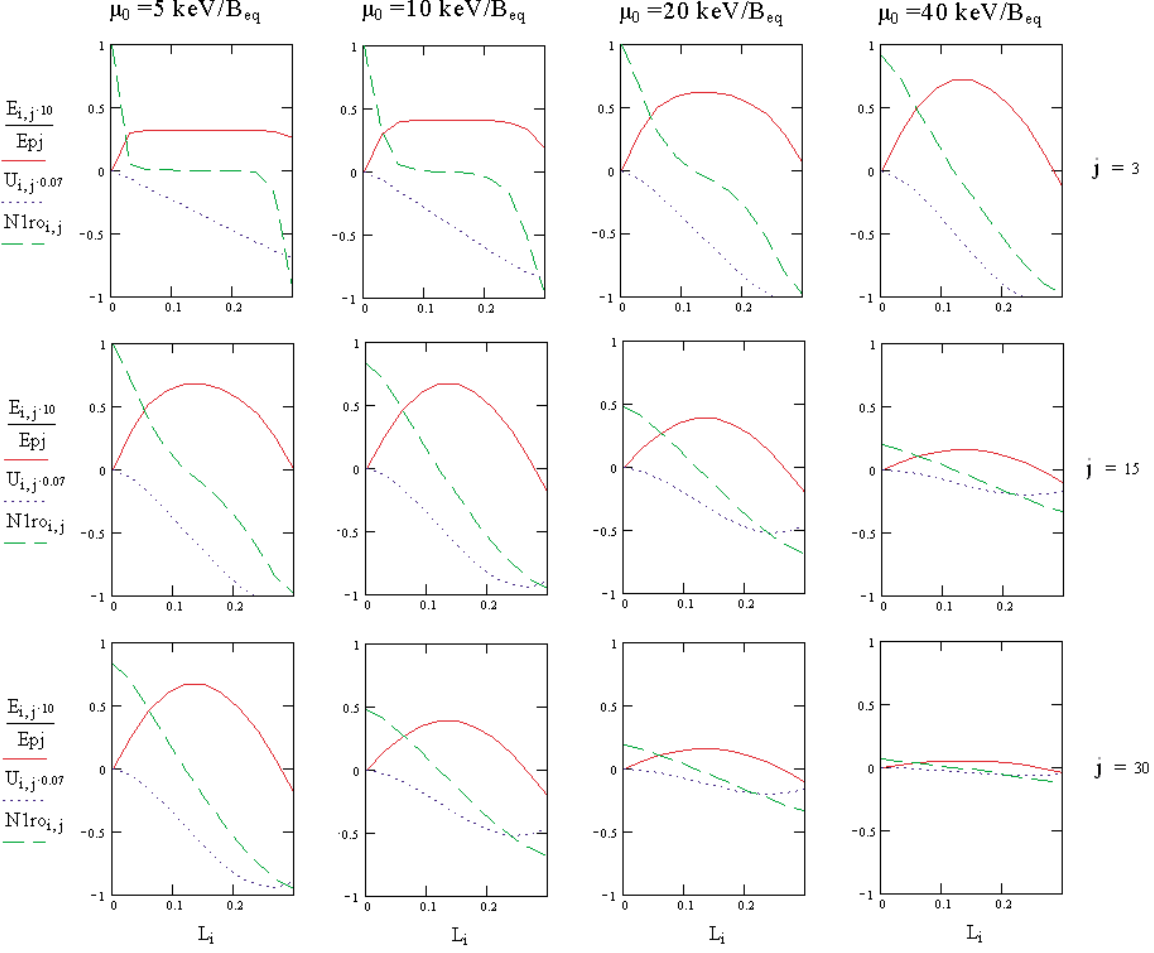
Fig. 4. Modelled cross-PJ profiles of the normalized charge density N r 0 , electric field E eq and potential U eq for the distribution functions with µ 0 = 5 , 10 , 20 and 40keV/ B eq (4 columns) at the times 18, 90 and 180min after the start of the quasi-steady stage (3 rows).